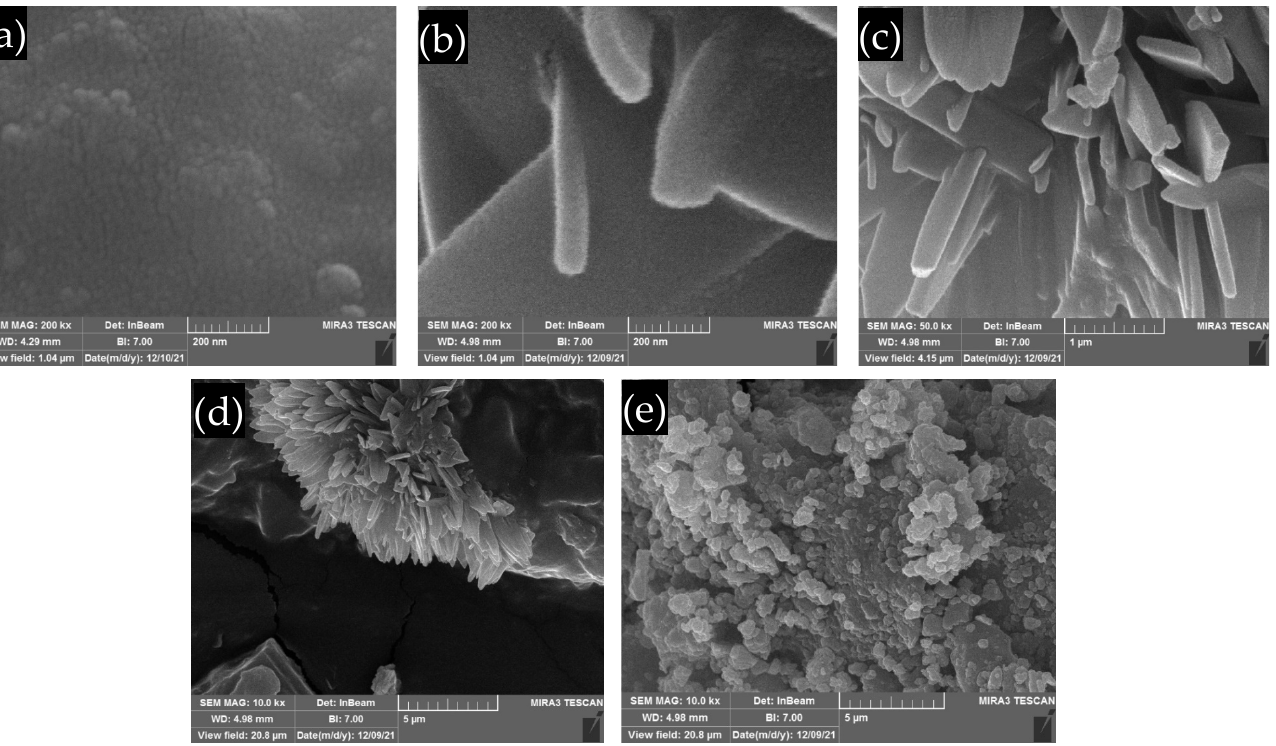
Figure 4. FE-SEM images of ( a ) pure acrylic polymer, and acrylic polymer/cement nanocomposites contains ( b ) 1 wt% ( c ) 2 wt% ( d ) 4 wt% ( e ) 8 wt%